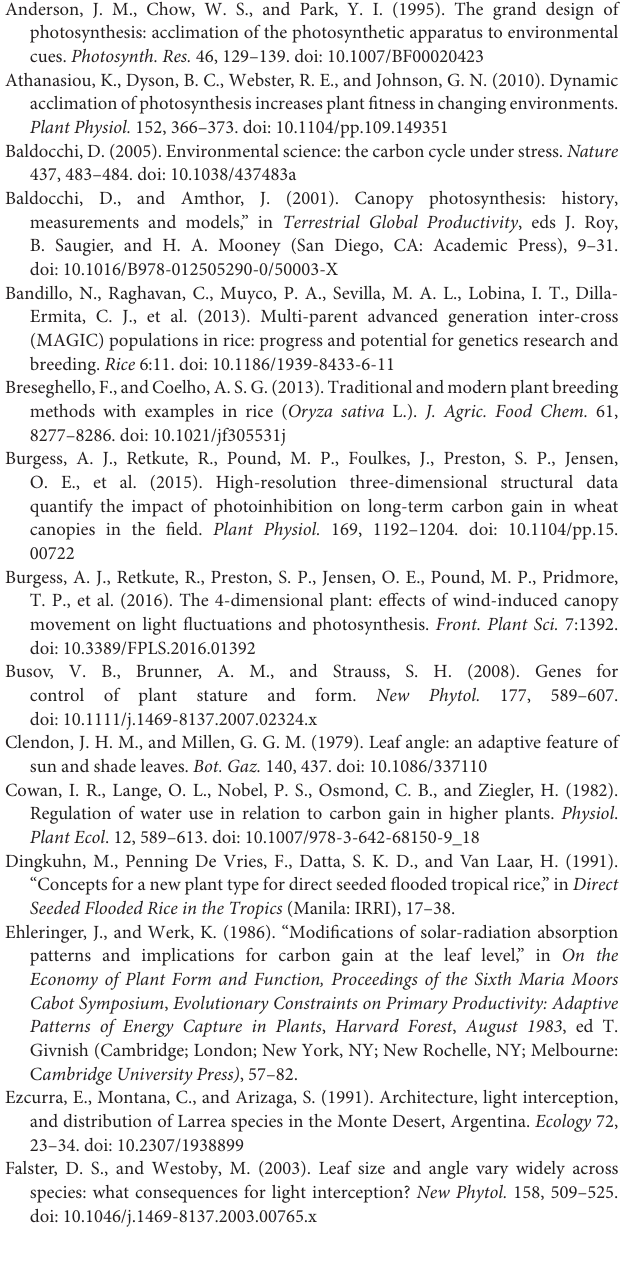
lines taken from Bandillo et al. (2013). The four MAGIC lines plus IR64 selected for in depth study are given in bold. Supplementary Table S2 | Physiological characteristics of the 15 parental MAGIC lines + IR64 used in the initial screening. All measurements, apart from harvest dry weight and seed dry weight, were taken 55–60 days after transplanting (DAT), corresponding to the vegetative growth stage. SPAD and leaf discs for chlorophyll samples were taken on the last full expanded leaf. The means of three plots are shown with standard errors of the mean. The bold lines are those selected for use in the in depth study due to their contrasting physiological